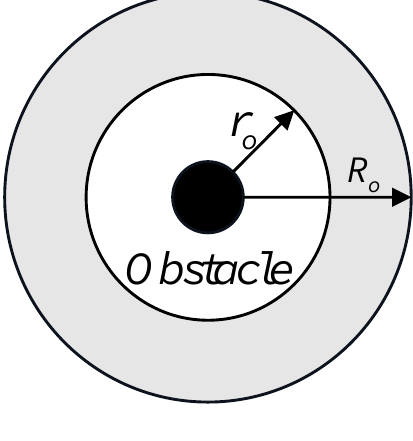
Figure 5. Potential field